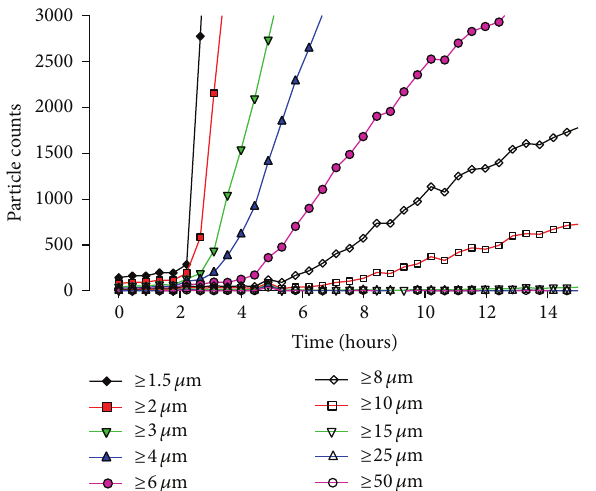
Figure 3: The particle size data versus time for a 15-hour period presenting the cumulative counts at various sizes including ≥ 1.5 𝜇 m (diamonds), ≥ 2.0 𝜇 m (squares), ≥ 3.0 𝜇 m (downward triangles), ≥ 4.0 𝜇 m (upward triangles), ≥ 6.0 𝜇 m (circles), ≥ 8.0 𝜇 m (empty diamonds), ≥ 10.0 𝜇 m (empty squares), ≥ 15 𝜇 m (empty downward triangles), ≥ 25 𝜇 m (empty upward triangles), and ≥ 50 𝜇 m (empty circles), for the 12.7 mmol/L [Ca 2+ ] sample.